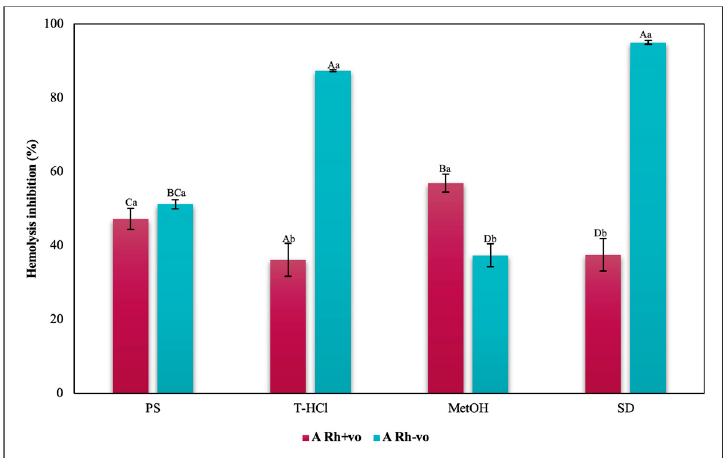
Figure 14. Inhibitory effect of hypotonicity-induced hemolysis of P. cruentum extracts on human erythrocytes with different RhD (positive and negative) of A blood group. Different letters represent significant differences in the means between treatments and groups ( p ≤ 0.001). Capital letters represent a two-way ANOVA. Lowercase letters represent a univariate ANOVA between the extracts. PS, extract of physiological solution; T-HCl, 0.5 M Tris-HCl extract; MetOH, 99% methanol extract; SD, sodium diclofenac.